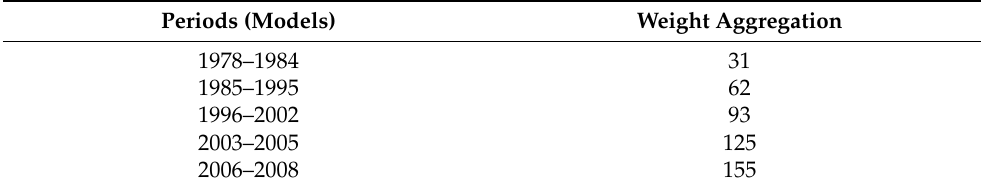
Table 4. Weight aggregation in different periods. Periods